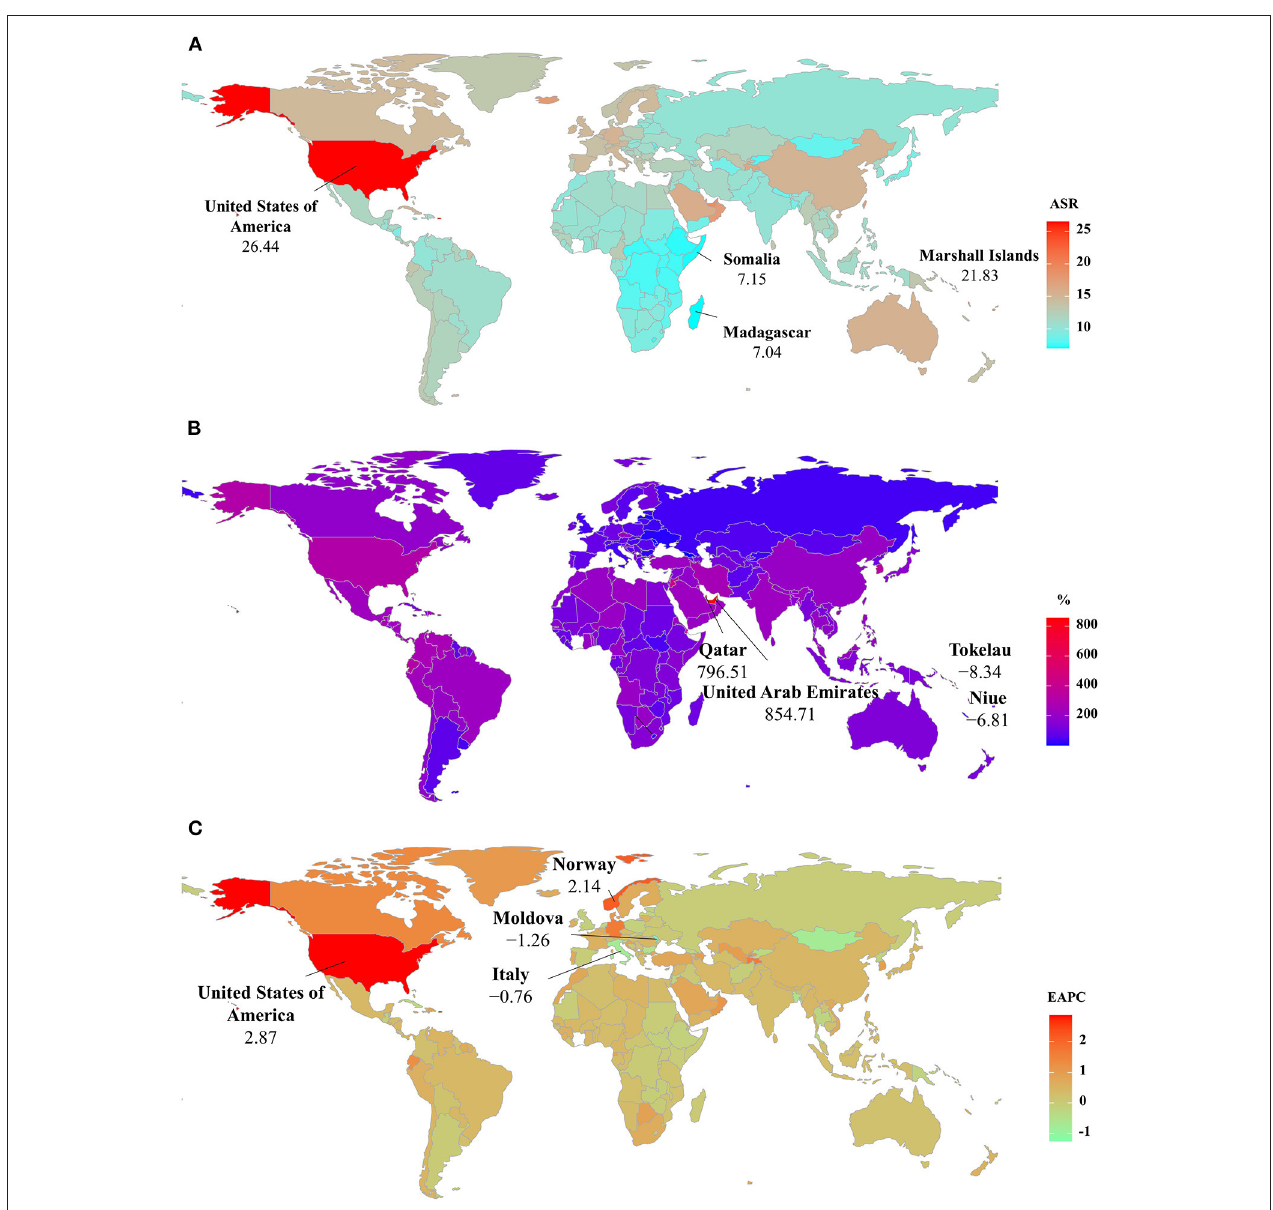
FIGURE 4 | The distribution of ASRs, percentage changes, and EAPCs of Parkinson’s disease incidence at the national level. (A) was the ASR in 2019; (B) was the percentage changes in number between 2000 and 2019; (C) was the EAPCs in countries/territories, respectively. Countries/territories with an extreme value were annotated. ASR, age-standardized rate; EAPC, estimated annual percentage